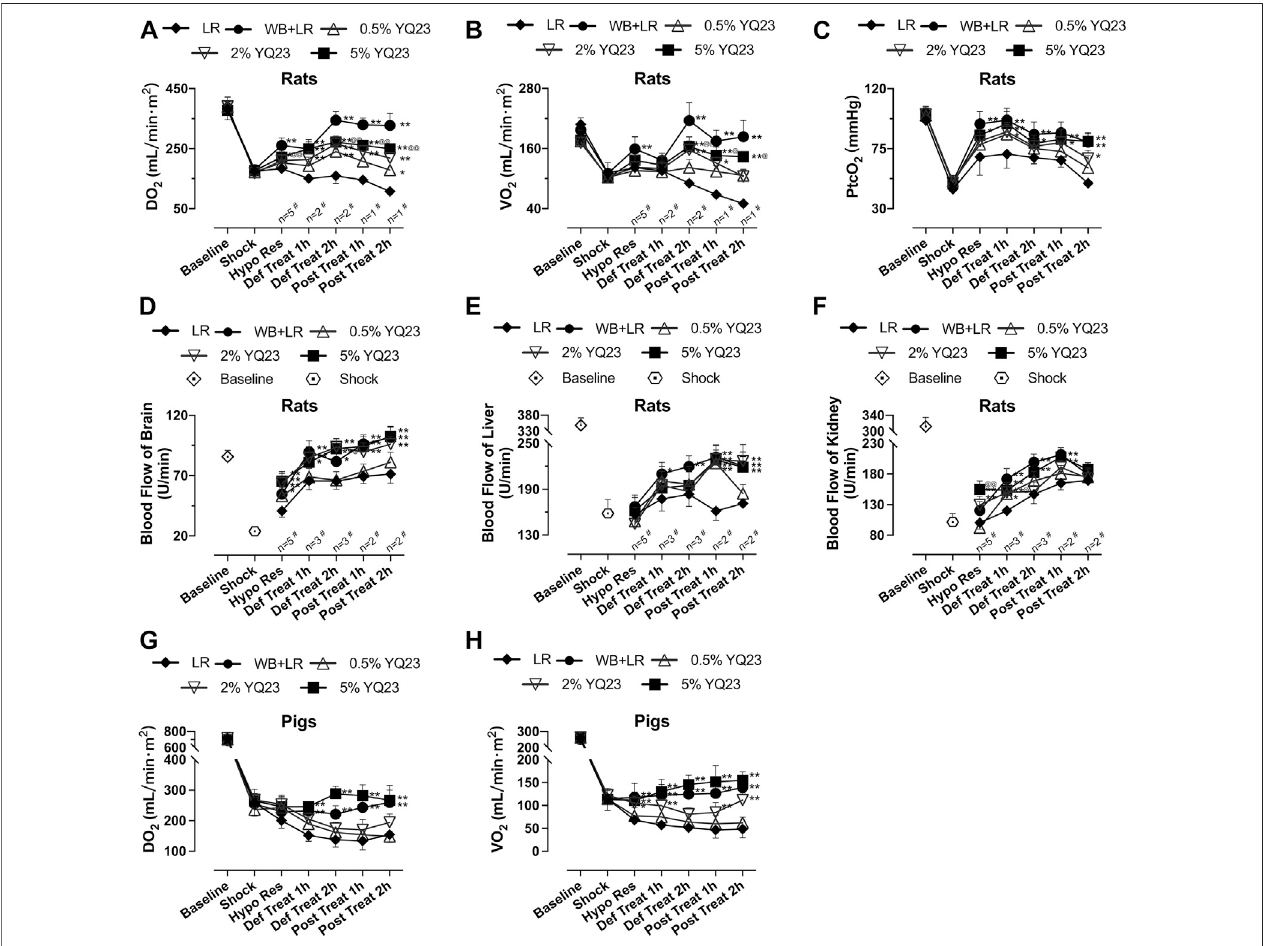
FIGURE 4 | YQ23 restored oxygen delivery, oxygen utilization, and organ blood perfusion following uncontrolled hemorrhagic shock in rats and pigs.(A) ,DO 2 inrats; (B) ,VO 2 inrats; (C) ,PtcO 2 inrats( n (cid:1) 2forLRgroup); (D) ,theblood fl owofthebraininrats; (E) ,theblood fl owoftheliverinrats;(F),theblood fl ow ofthekidneyinrats; (G) ,DO 2 inpigs; (H) ,VO 2 inpigs( n (cid:1) 10/groupinratsexperimentunlessotherwiseannotated,n (cid:1) 6/groupinpigexperiment).DO 2 ,oxygendelivery; VO 2 , oxygen consumption; PtcO 2 , the transcutaneous partial pressure of oxygen LR, Lactate Ringer ’ s solution; WB, whole blood. * p < 0.05 v. s. LR at the same timepoint,** p < 0.01v.s.LRatthesametimepoint, @ p < 0.05v.s.WB+LRatthesametimepoint, @@ p < 0.01v.s.WB+LRatthesametimepoint, # nofLRgroupat the corresponding time point (sample size was decreased because of animal